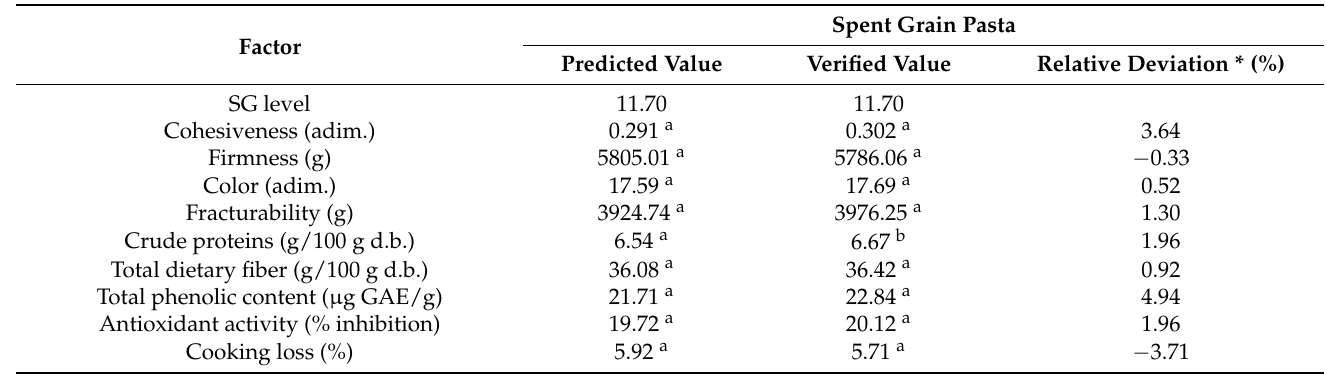
Table 4. Predicted and verified optimal sample.